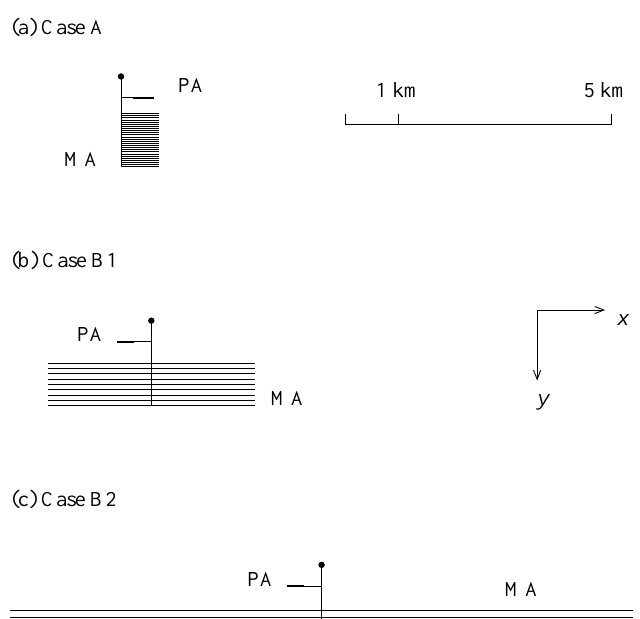
Figure 1. Generic repository designs from the top view; ( a ) case A repository with a roughly square disposal room area; ( b ) moderately stretched, case B1 repository composed of eighteen disposal galleries, head-to-head in pairs; ( c ) extremely stretched case B2 repository composed of six disposal galleries, head-to-head in pairs. MA: main disposal room area (envelope of disposal galleries). PA: pilot disposal room area; Coordinate system: The z -axis is perpendicular to the disposal plane and pointing downwards. Table 1. Outline characteristics of space-optimized (case A) and low-temperature (case B) configurations for the disposal of high-level waste and spent fuel in Opalinus clay.